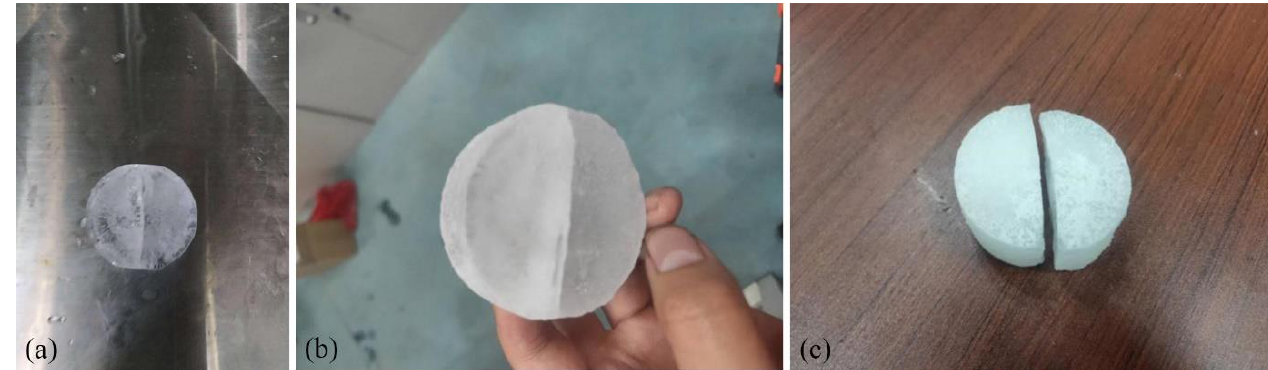
Figure 17. Split ice samples in tensile strength test. ( a ) Freshwater split ice sample. ( b ) Seawater split